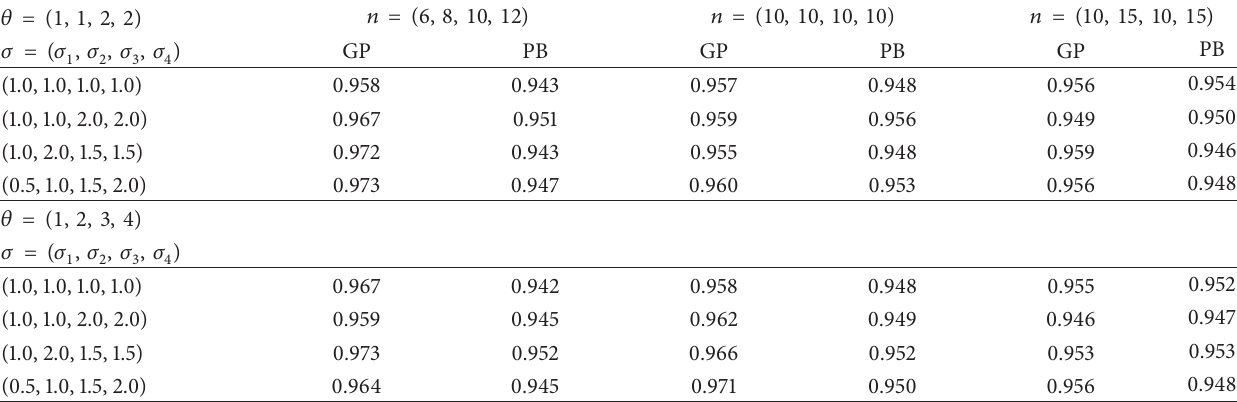
Table 2: Coverage probabilities of the simultaneous confidence